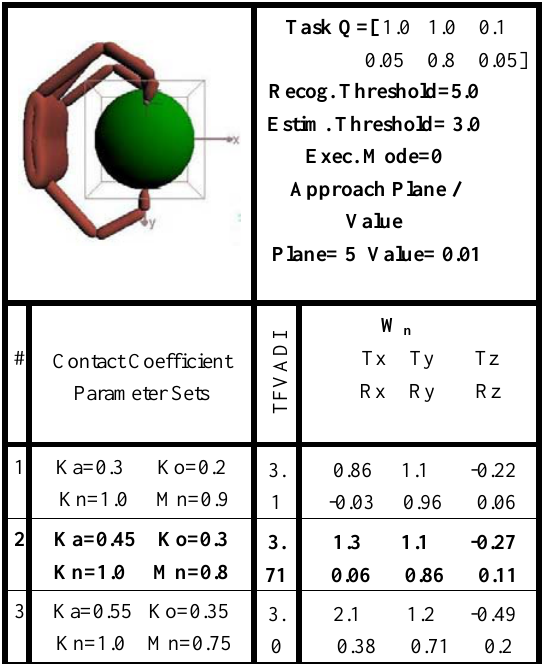
Figure 14 Sensitivity to Contact Coefficient Parameters. Figure 15 Sensitivity to Variations in